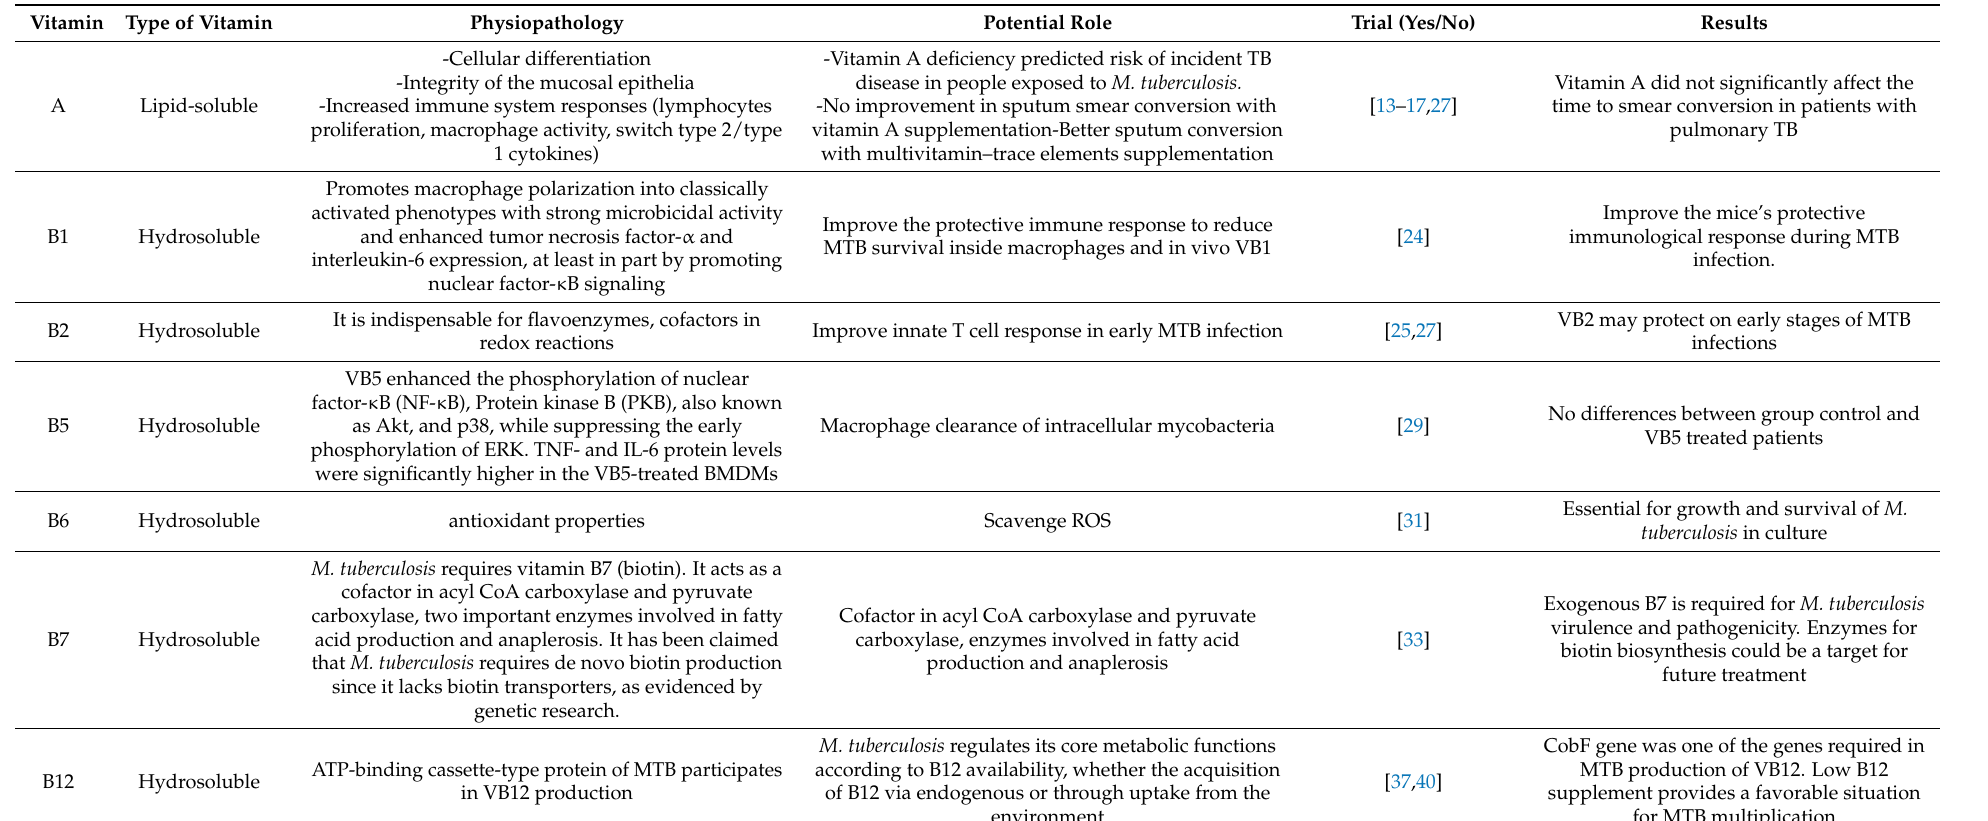
Table 1. Summary of Impact of Vitamins A, B, C, D and E on M. tuberculosis